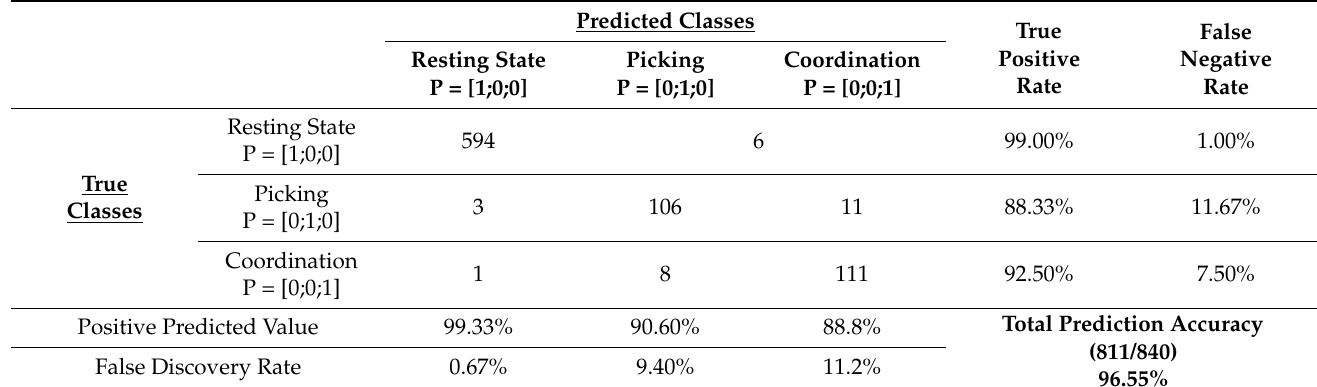
Table 4. Hierarchical classification results.